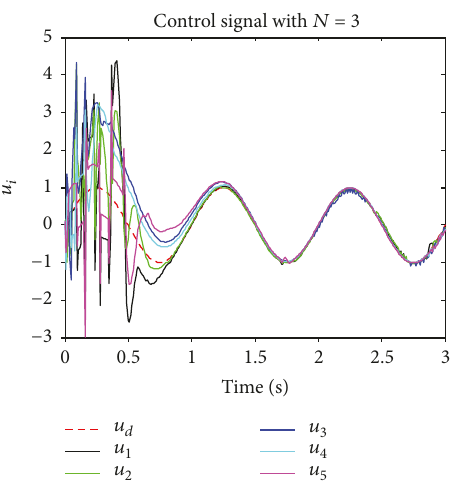
Figure 5: Control signal for Case